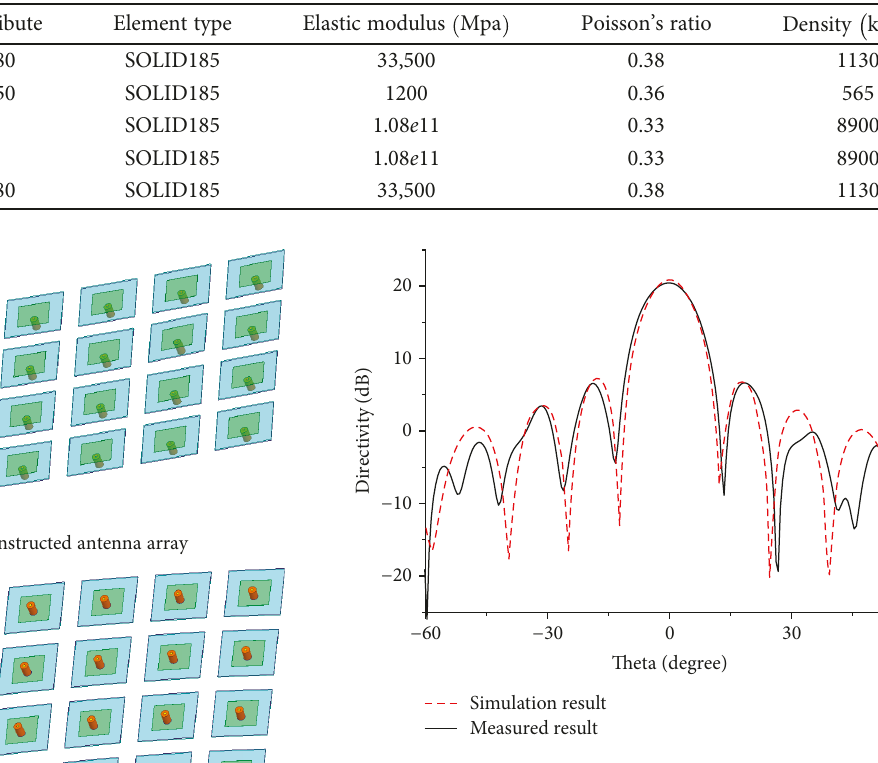
Figure 17: Radiation pattern without considering fi eld coupling. Table 2: Comparison of measured and simulation results.